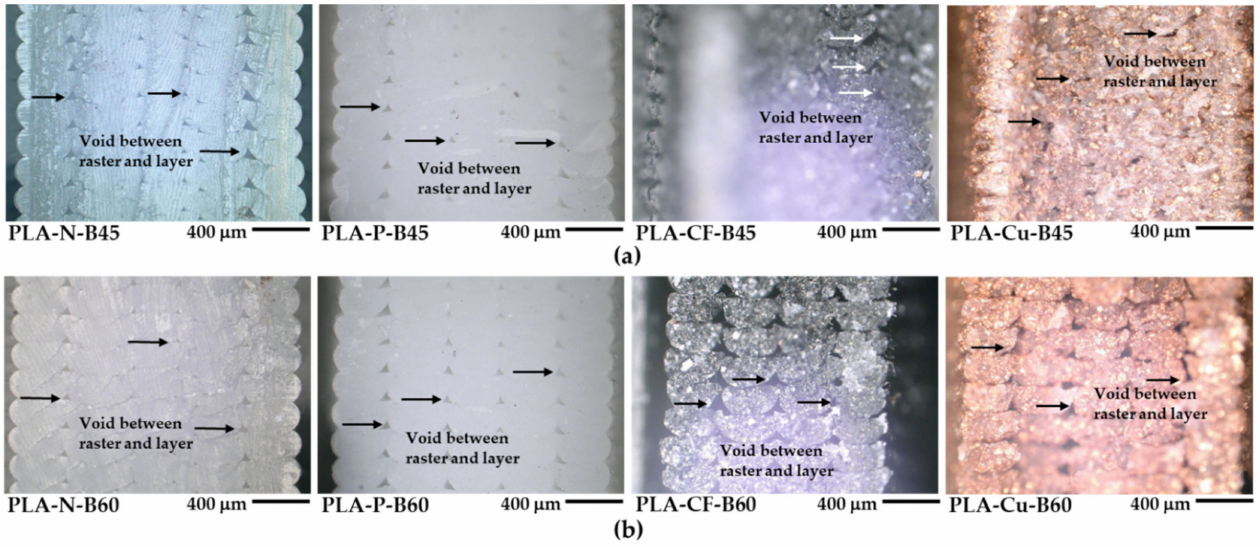
Figure 12. Optical micrographs of 3D printed samples: ( a ) at bed 45 ◦ C and ( b ) at bed 60 ◦